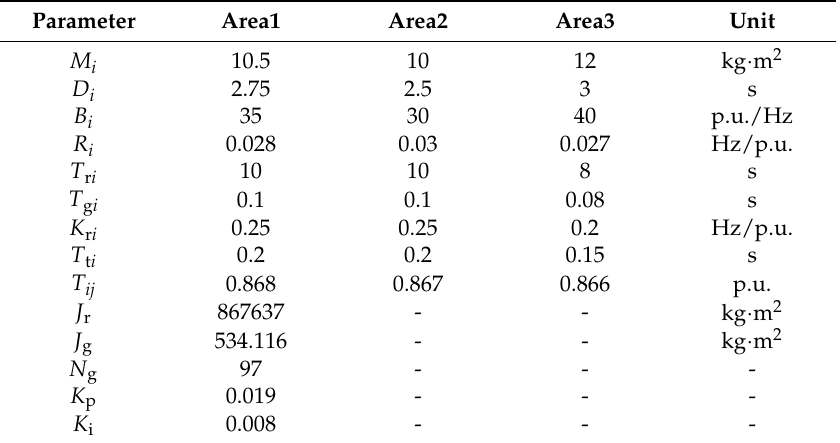
Table 2. AGC system simulation parameter.